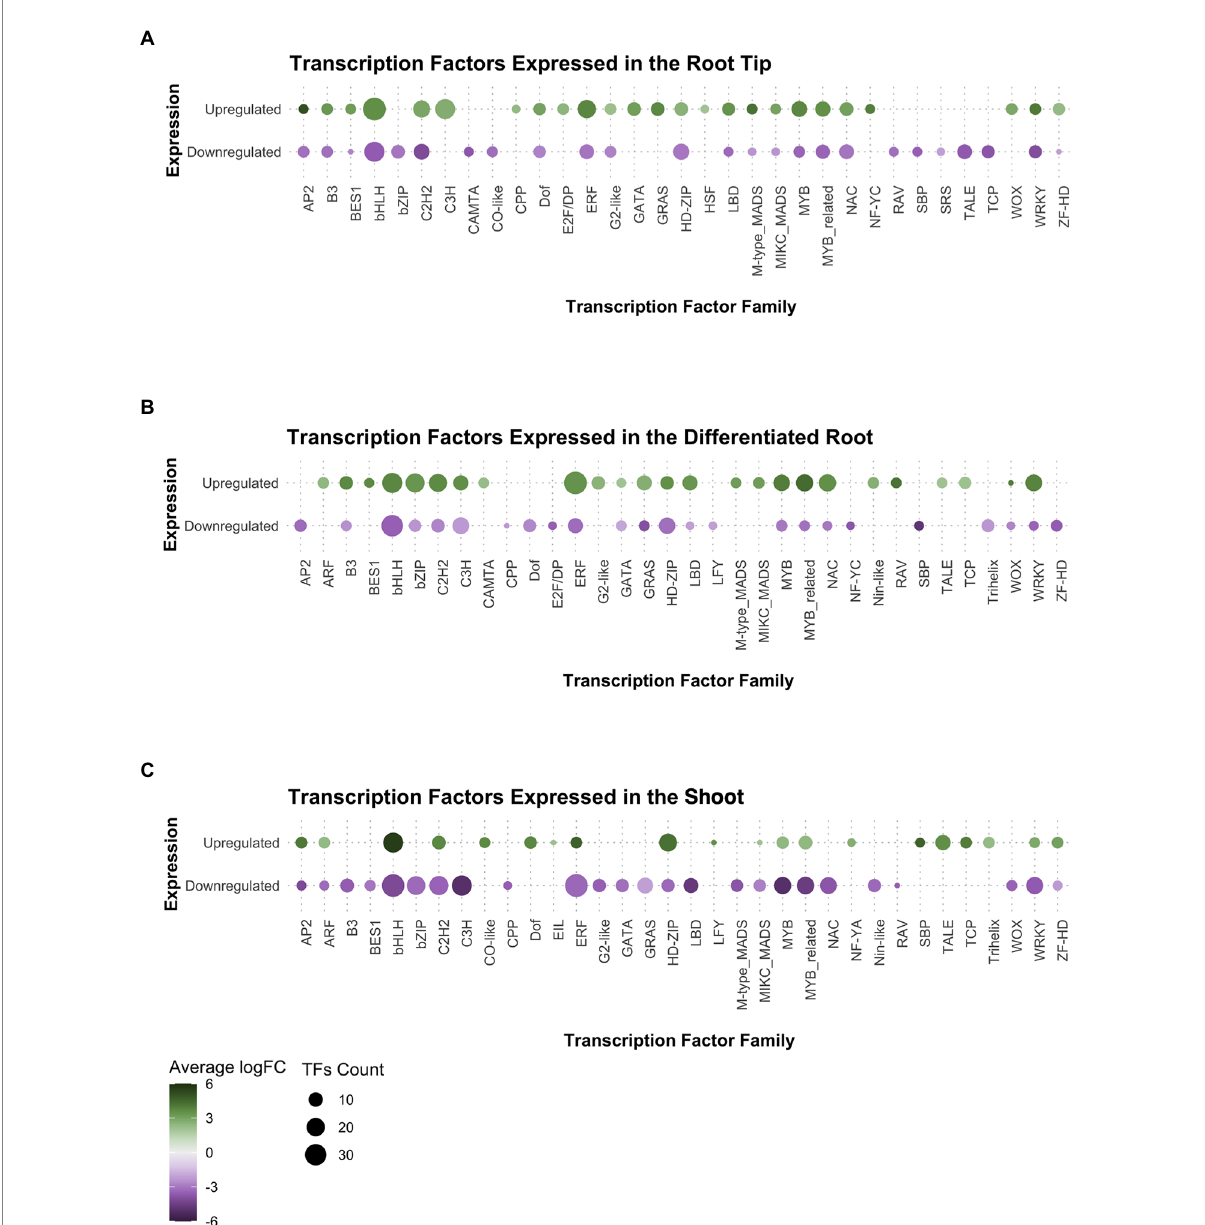
FIGURE 3 Analysis of gene expression in the transcription factor families found in Ceratopteris transcriptome per tissue: (A) the root tip, (B) the differentiated root, and (C) the